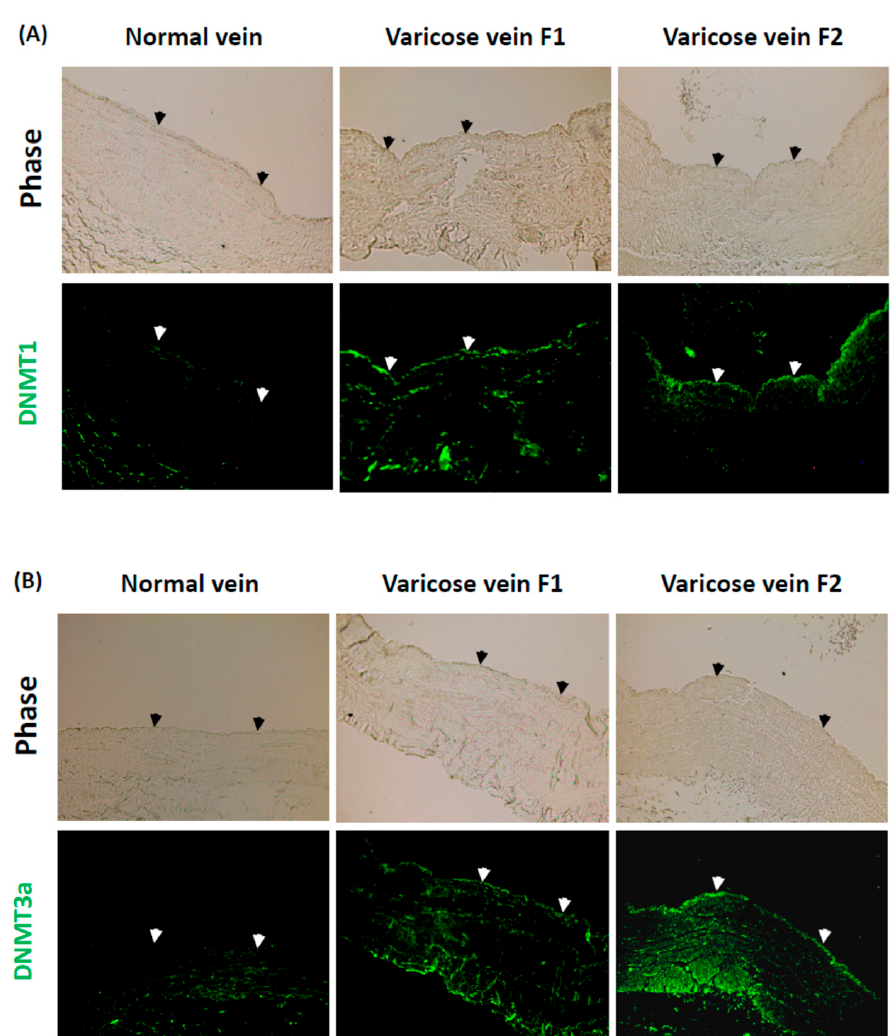
Figure 3. DNA methyltransferases (DNMTs; DNMT1 and DNMT3a) are over-expressed in the endothelium of human varicose veins with blood reflux but are inhibited in human normal veins with normal venous flow. Cross-sections of human varicose veins with different levels of blood reflux (varicose veins F1 and F2) and human normal veins with normal venous flow (normal vein) were immunostained for detecting DNMT1 ( A ) and DNMT3a ( B ). Arrows represent the endothelia in the blood vessel. All photographs were obtained with fluorescence microscope with a 10× objective.